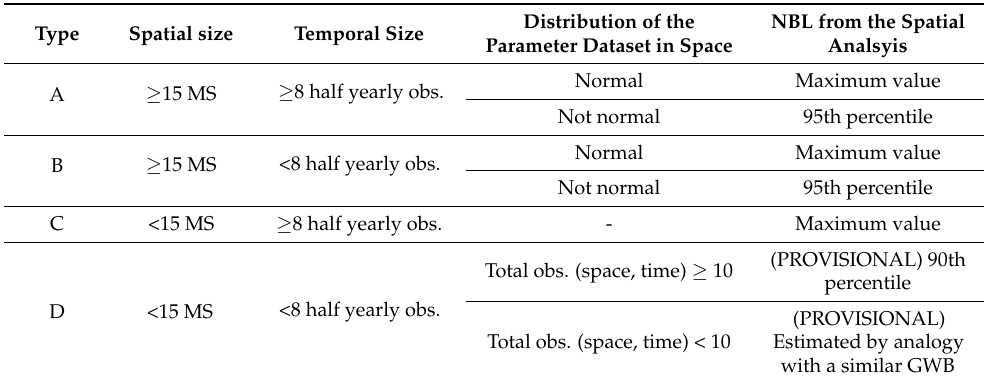
Table 1. Type of dataset following the size in space (number of monitoring stations) and time (number of observations in time) and relative procedure for NBL calculation (steps 8 to 10).